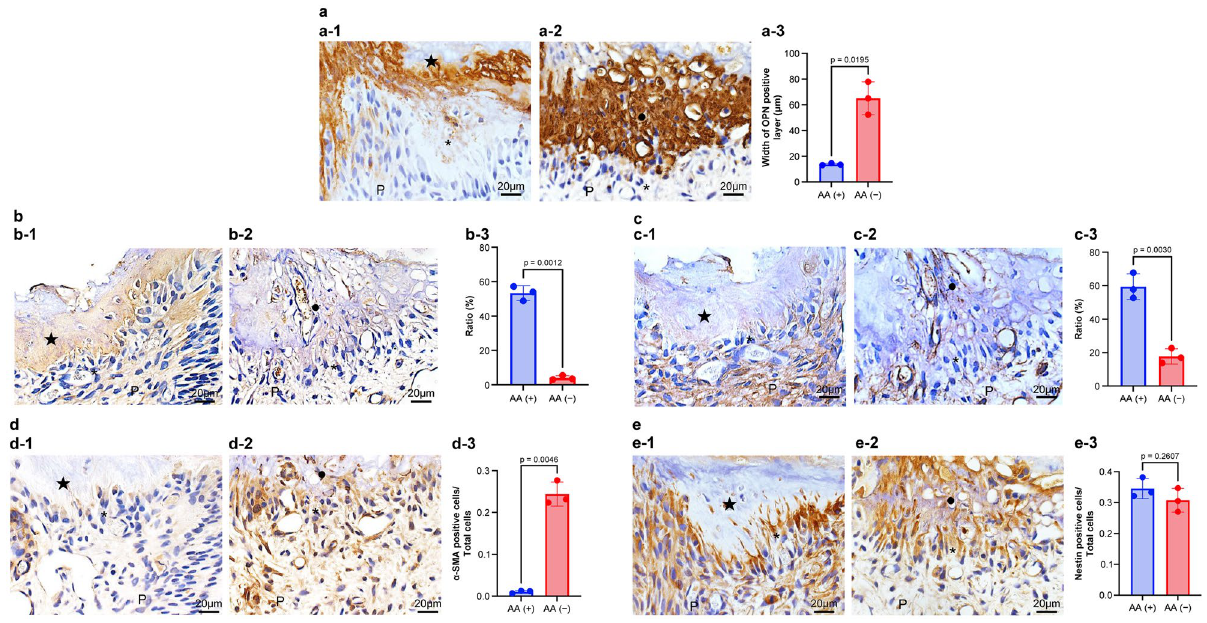
Figure 5. Immunohistochemical alteration of osteopontin (OPN), type I collagen (Col I), type III collagen (Col III), α-smooth muscle actin (α-SMA), and Nestin in the pulp tissue of ODS rat 7 days after pulpotomy followed by MTA capping. Immunohistochemical staining of ( a ) OPN, ( b ) Col I, ( c ) Col III, ( d ) α-SMA, and ( e ) Nestin. (a-1, b-1, c-1, d-1, and e-1) ODS rats fed a normal diet (control; group 1). (a-2, b-2, c-2, d-2, and e-2) ODS rats fed an ascorbic acid-free diet (AA deficiency: group 2). Data exhibit quantification of OPN, α-SMA, and Nestin (a-3, d-3, and e-3), or rations of Col I and Col III (b-3 and c-3). Bars exhibit mean values ± standard error of the mean compared with controls (group 1), (n = 3 for each group; only comparisons with p -value ≤ 0.05 are shown), Welch’s t-test. The OPN-immunopositive layer is observed above the reparative dentin in group 1 (a-1), whereas the thick OPN-positive (necrotic) layer is found in group 2 (a-2). The OPN layer of group 2 is thickened in the necrotic layer (a-3). The reparative dentin is positive for the Col I immunoreactivity of